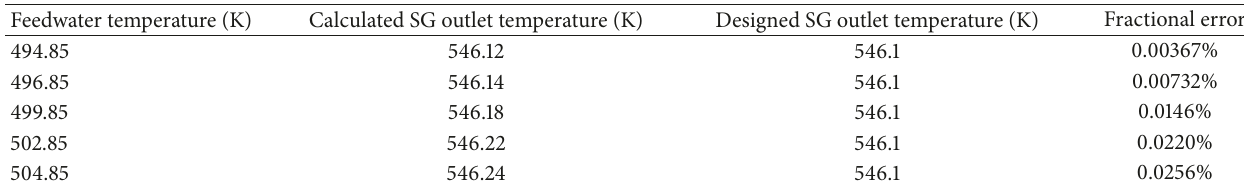
Table 15: The influence of feedwater temperature on the SG outlet temperature.